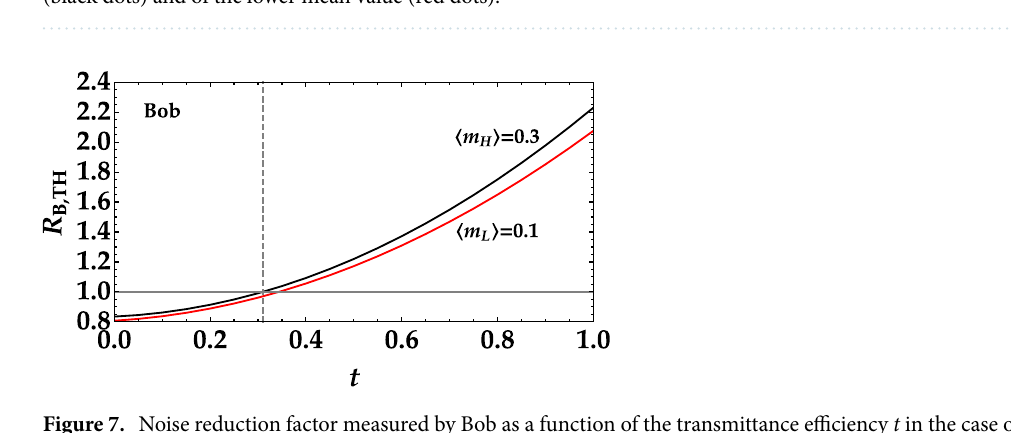
Figure 6. Noise reduction factor as a function of the number of shots in the case of the higher mean value (black dots) and of the lower mean value (red dots).